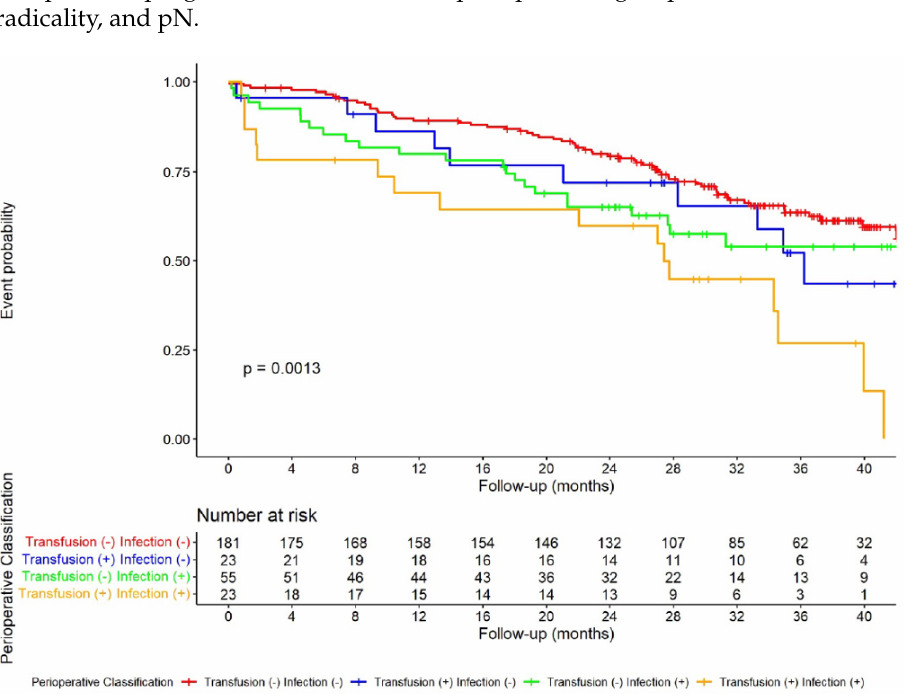
Figure 2. Kaplan–Meier analysis of probability of disease-free survival according to the perioperative